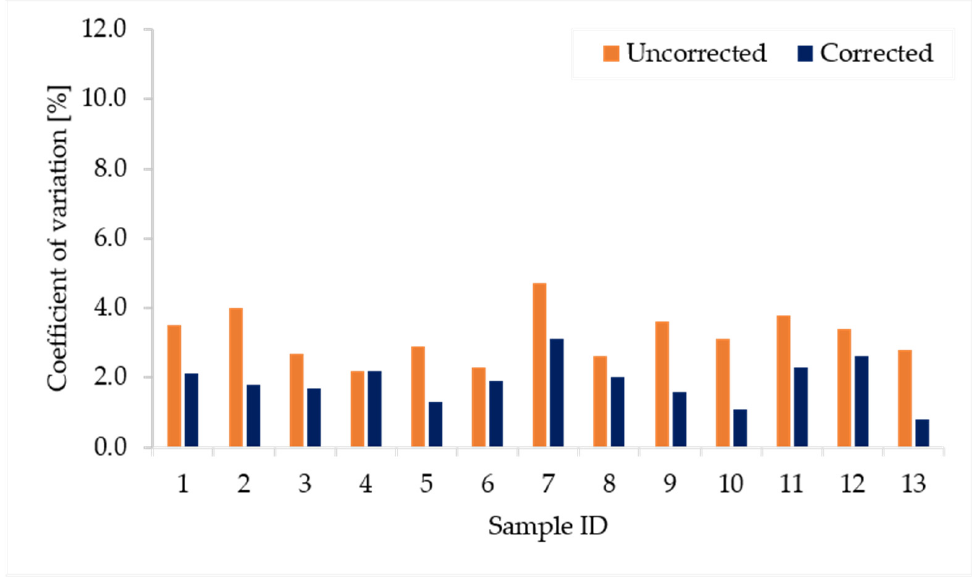
Figure 11. Coefficients of variation between HVIs for the 25% SL over 13 USDA commercial samples before and after correction.